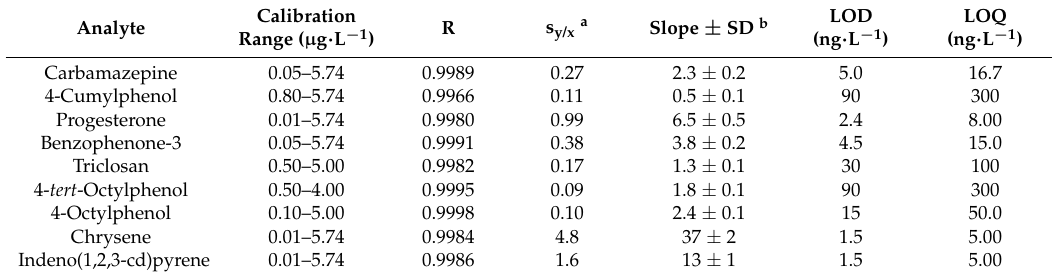
Table 2. Several quality analytical parameters of the D- µ SPE-HPLC-DAD method.